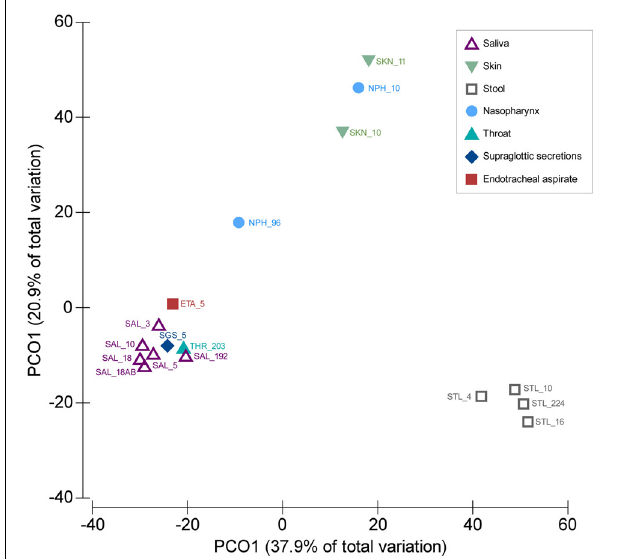
FIGURE 1 | Similarities between SGS, ETA, and bacterial communities from other body parts. PCoA was based on Bray–Curtis similarity matrix constructed using square-root transformed average relative abundance of genera. The number following underscore corresponds to the number of subjects analyzed. Saliva samples: SAL_192 (Segata et al., 2012), SAL_10 (Ling et al., 2013), SAL_18 (from children, before antibiotic treatment) (Lazarevic et al., 2013b), SAL_18AB (from children, at the end of the antibiotic treatment) (Lazarevic et al., 2013b), SAL_5 (three time points for each subject) (Lazarevic et al., 2010), SAL_3 (Zaura et al., 2009). Throat swab: THR_203 (Segata et al., 2012); Supraglottic secretions: SGS_5 (five time points for each subject, this study); Endotracheal aspirate: ETA_5 (five time points for each subject, this study). Skin samples: SKN_10 (Ling et al., 2013), SKN_11 (MG-RAST ID 6526); Nasopharyngeal swabs: NPH_96 (Bogaert et al., 2011), NPH_10 (Ling et al., 2013). Stool samples: STL_224 (Segata et al., 2012), STL_10 (Ling et al., 2013), STL_16 (five time points for each subject) (Krych et al., 2013), STL_4 (data designated V4-0.5) (Claesson et al., 2009). The abundance of genera were taken directly from the tables provided in corresponding publications, except for the SKN_11 (unpublished) for which the MG-RAST data were processed using the bioinformatics pipeline as described in this paper.